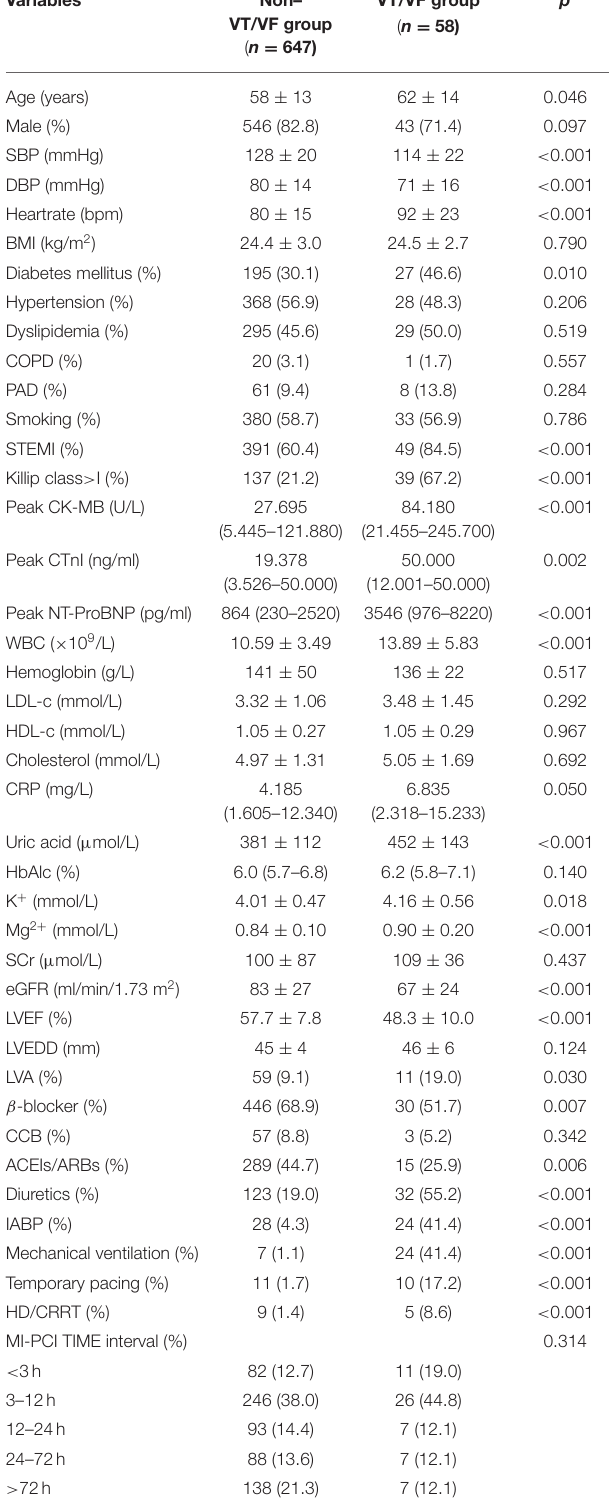
TABLE 1 | Baseline characteristics of patients in the non–VT/VT group and the VT/VF group.